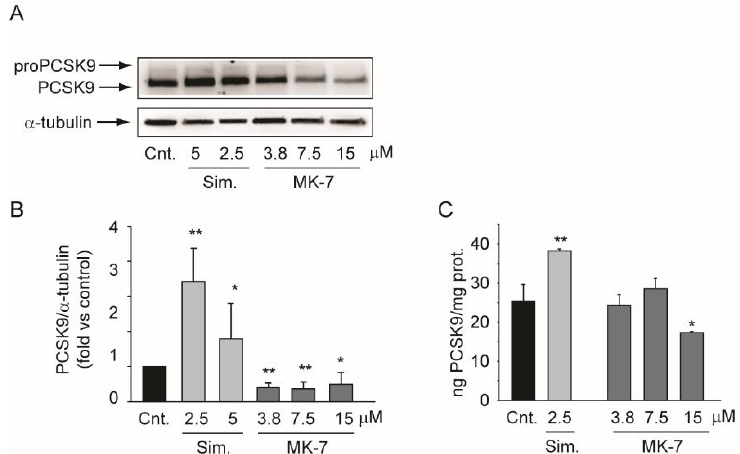
Figure 5. E ff ect of MK-7 on PCSK9 expression. ( A ) Human hepatoma cells were incubated for 24 h with indicated concentrations of simvastatin and MK-7. PCSK9 protein expression was evaluated by Western blot analysis. α -tubulin was used as the loading control. ( B ) Densitometric readings were evaluated using ImageLab TM software. ( C ) Cells were treated under the same experimental conditions as panel A and the conditioned media were analyzed by ELISA to determine PCSK9 concentrations. The data were normalized for the total cell protein. Di ff erences between treatments were assessed by Student’s t test. * p < 0.05 vs. control; ** p < 0.01 vs. control; Sim.: